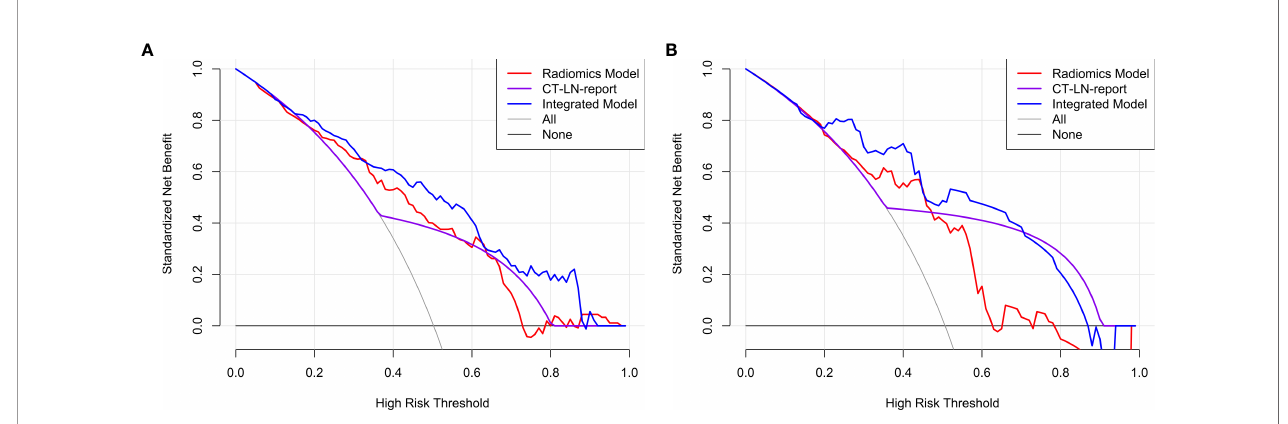
FIGURE 6 | The DCA for the Integrated Model, Radiomics Model, and CT_LN_report in training (A) and test cohorts (B) .